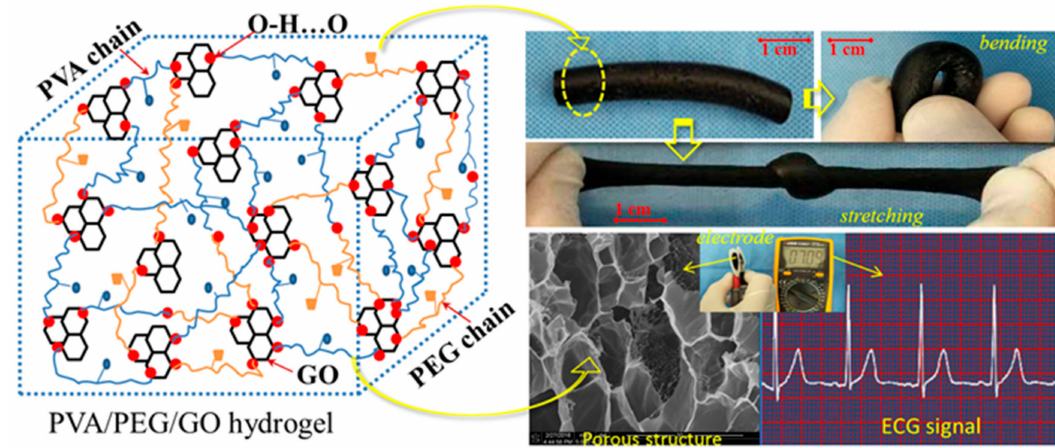
Figure 9. Polyvinyl alcohol/PEG/GO hydrogels blending with GO using the freezing thawing method (reproduced from [138] under open access